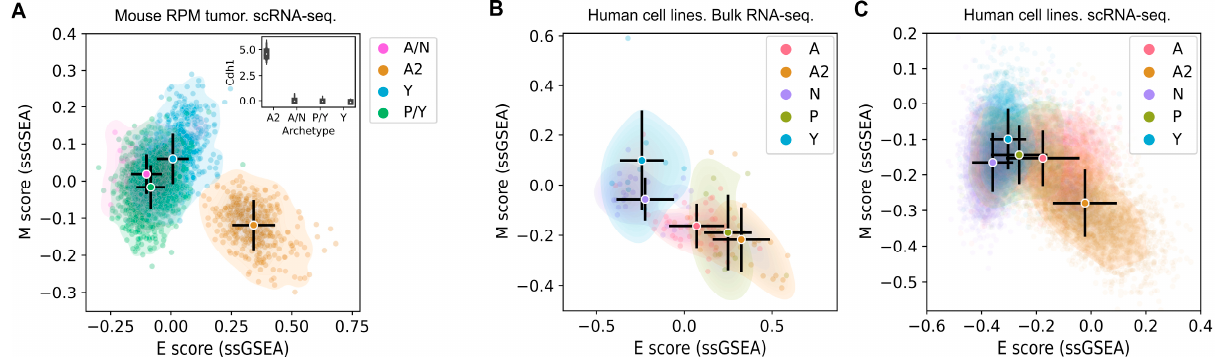
Figure 1. Distributions of SCLC cells across the epithelial and mesenchymal spectrum. E and M scores of ( A ) 15,138 mouse Myc -overexpressing SCLC GEMM tumor cells in an ex vivo model; ( B ) 120 SCLC cell lines; and ( C ) 13,945 cells from eight SCLC cell lines. Scores were computed with ssGSEA and 425 previously identified EMT genes. Circles and black bars indicate means and standard deviations. Inset in A shows normalized expression of Cdh1 in four classes of cells.